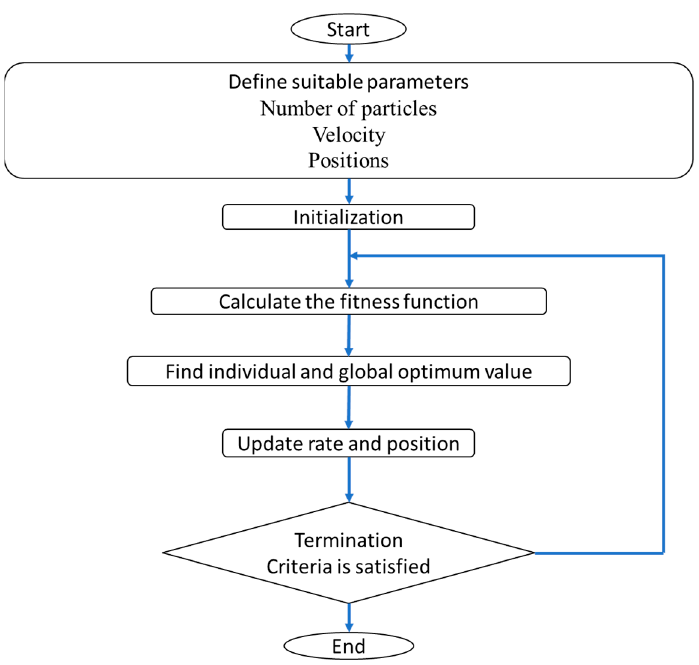
Figure 7. Particle swarm optimization algorithm.